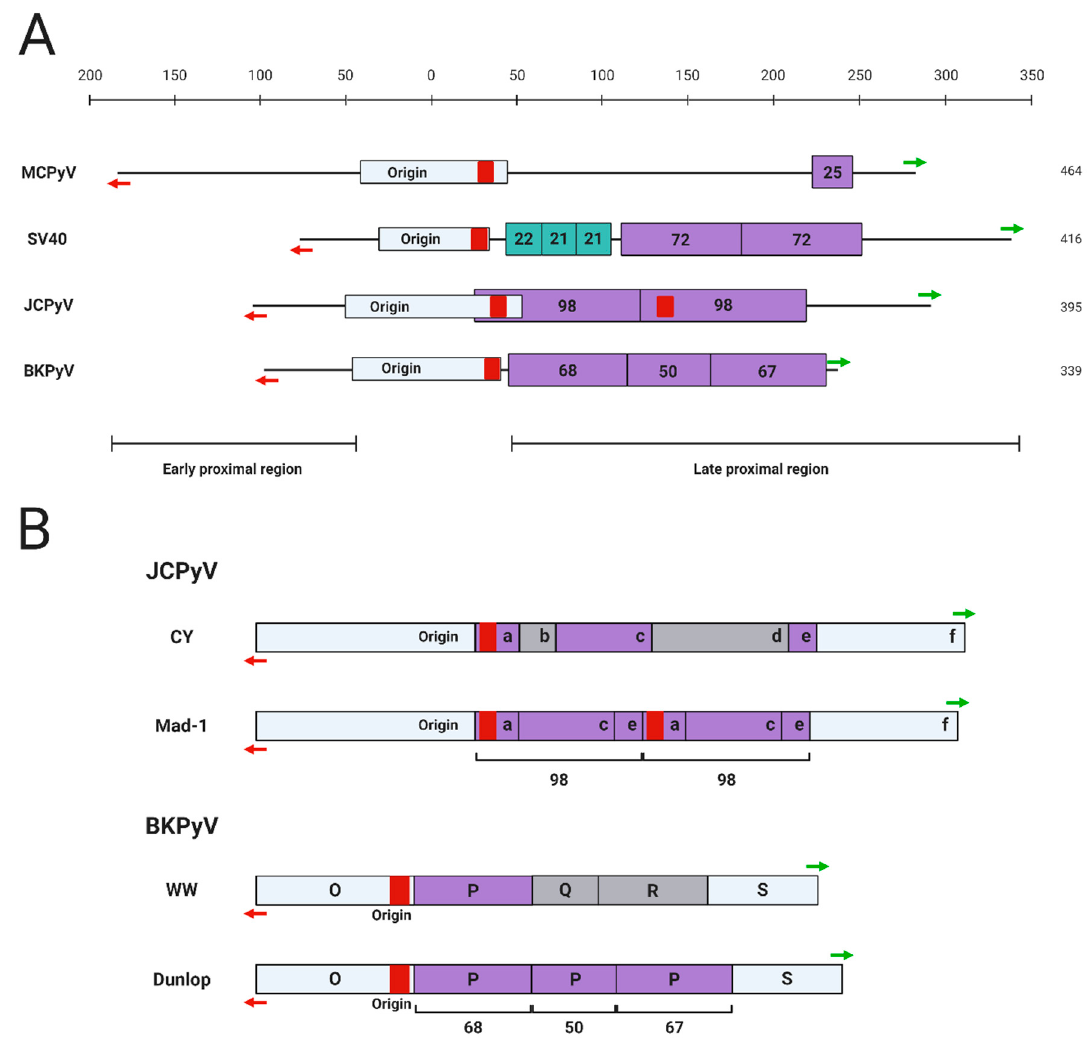
Figure 2. Structure of primate polyomavirus NCRRs. ( A ) The full NCRRs of MCPyV (R17b, GenBank accession no. NC_010277.2), SV40 (776, GenBank accession no. NC_001669.1), JCPyV (Mad-1, GenBank accession no. NC_001699.1), and BKPyV (Dunlop, GenBank accession no. NC_001538.1) are shown. The total nucleotide length of each NCRR is indicated on the right. The origin of replication for each polyomavirus contains a poly A/T tract (red bar), which is duplicated in JCPyV Mad-1. The directions of early and late transcription are shown as red and green arrows, respectively. Enhancer-associated tandem repeat elements in SV40, JCPyV Mad-1, and BKPyV Dunlop are shown in purple. The 25-base pair region of MCPyV duplicated in the Japanese strains (GenBank accession no. LC348865.1) is also highlighted in purple. The SV40 promoter-associated 21-bp tandem repeat elements are marked in turquoise. The approximate early and late proximal regions are indicated. ( B ) The poly A/T tract is indicated as a red bar, and directions of early and late transcription are shown as red and green arrows, respectively. NCRR regions conserved between the prototypical and archetypal strains are shown in purple; regions present in only the archetypal NCRR are shown in gray. The JCPyV archetype (CY, GenBank accession no. AB038249.1) NCRR consists of an early proximal region containing the origin followed by regions a, b, c, d, e, and f. The JCPyV prototype Mad-1 NCRR is arranged as Origin-a-c-e-a-c-e-f [18]. The BKPyV archetype (WW, GenBank accession no. AB211371.1) NCRR consists of an O region (containing the origin), followed by P, Q, R,